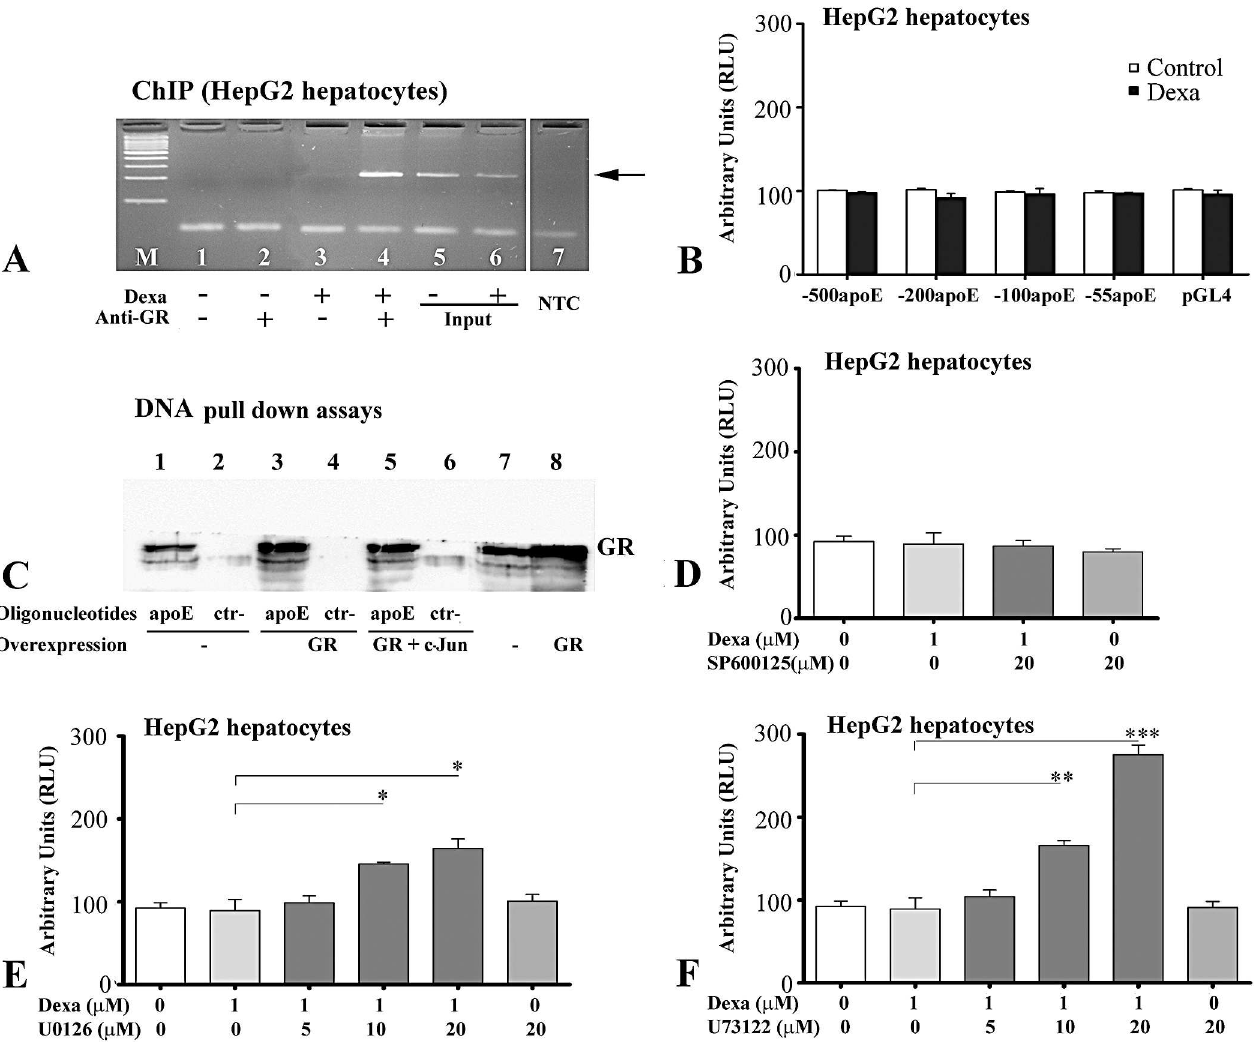
Fig 7. In hepatocytes, glucocorticoid receptors (GRs) bind to apoE proximal promoter but are not capable to regulate apoE gene expression due to the interaction with other signaling pathways. (A) Dexamethasone inducesGR recruitment to apoE promoterin HepG2 hepatocytes as revealed by ChIP assay (lane 4). In the absenceof the ligand, GRs do not bind to apoE promoter (lane 2). In controls, the chromatin of dexamethasone-treated or untreatedcells was processedomitting the antibodies(lanes 3 and 1, respectively). PCR using the input prepared from treated or untreatedcells as template producedthe expectedbands (lanes 5 and 6, respectively). The arrow indicates the specific 258 bp band corresponding to apoE promoter, that is absent in the no template control reaction(lane 7, NTC). In lane 1 (M), marker DNA ladderis shown. (B) In transientlytransfected HepG2 cells, exposureto dexamethasone does not significantly enhancethe activity of [-500/+73] apoE promoter, its deletionfragmentsor pGL4 vector, used as a control (p > 0.05). (C) DNA pull down experiments show that GR bind to the -115/-75apoE promoter regionin untransfected cells (lane 1) and bindingis enhanced by overexpression of GR α (lane 3). A partial (~30%) inhibitionof GR bindingwas detected in cells overexpressing both GR and c-Jun (lane 5). No bindingoccurs to non-specific oligonucleotides when the cells express only endogenous GR (lane 2), overexpress GR (lane 4) or overexpress both GR and c-Jun (lane 6). Western blots probedfor GR α of whole extracts preparedfrom cells expressingonly the endogenousprotein or overexpressing it are illustratedin lanes 7 and 8, respectively.(D-F) The effects of variousinhibitorson dexamethasone-treatedHepG2 cells transiently transfected with plasmidscontaining luciferase under apoE proximal promoter. (D) Dexamethasone does not significantly modulateapoE promoter activity in the presenceor absenceof the JNK inhibitor, SP600125 (E) Exposure of HepG2 cells to dexamethasone (1 μ M, for 24 hours) in the presenceof increasing concentrations of MEK1/2 inhibitor(U0126) inducesa dose-dependent enhancement of apoE promoteractivity (F). Dexamethasone treatment in the presenceof PLA2/PLCinhibitorU73122 increasesapoE promoteractivity as a function of the inhibitor concentration. The symbols are: *** p < 0.001, ** p < 0.01and * p <